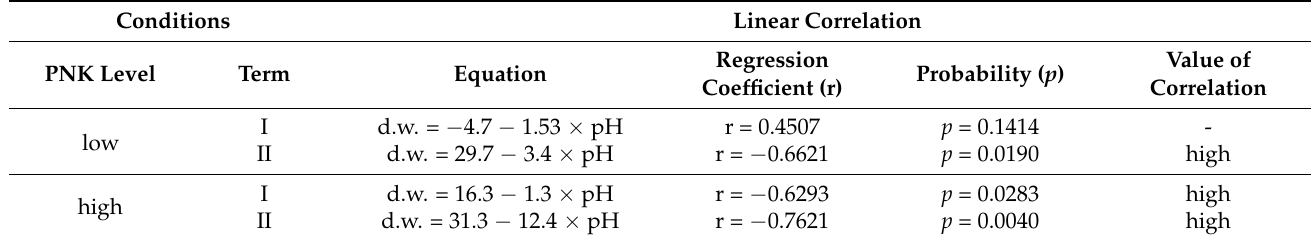
Table 11. The linear correlation between pH in water and dry weight of Hydrocharis morsus-ranae (g) in the three tested growing seasons.